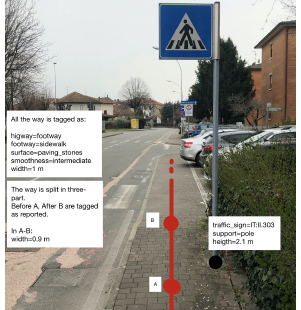
Figure 3. Example of mapping the height of a traffic sign.